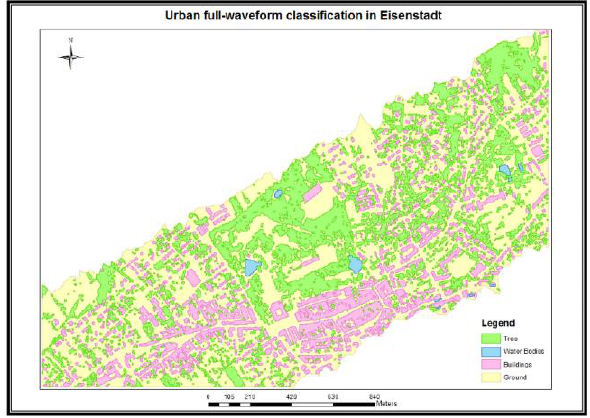
Figure 2. Urban full-waveform classification in Eisenstadt.